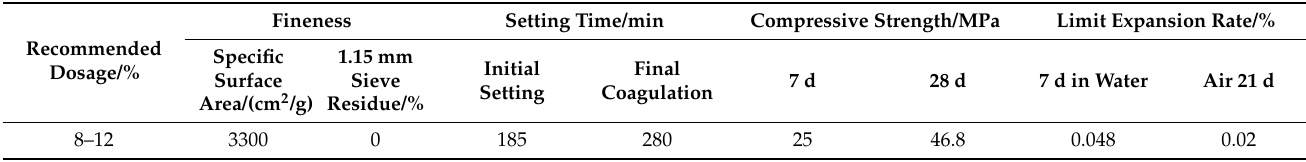
Table 3. Physical and chemical properties of HPEA.